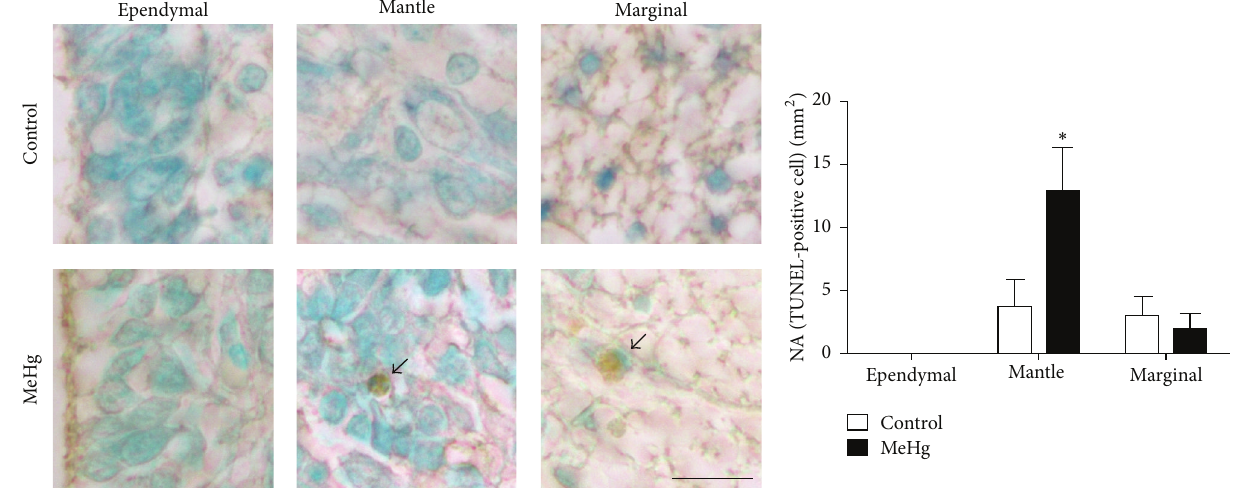
Figure 6: Apoptotic cells in the spinal cord of chicken embryos at E10 recognized by the TUNEL method. MeHg-treated and control embryos showed apoptotic cells (arrows) in the mantle and marginal layers. The accompanying graph displays the NA of TUNEL-positive cells in each spinal cord layer. Data are presented as mean ± SEM. ∗ 𝑃 < 0.05 . Scale bar: 10 𝜇